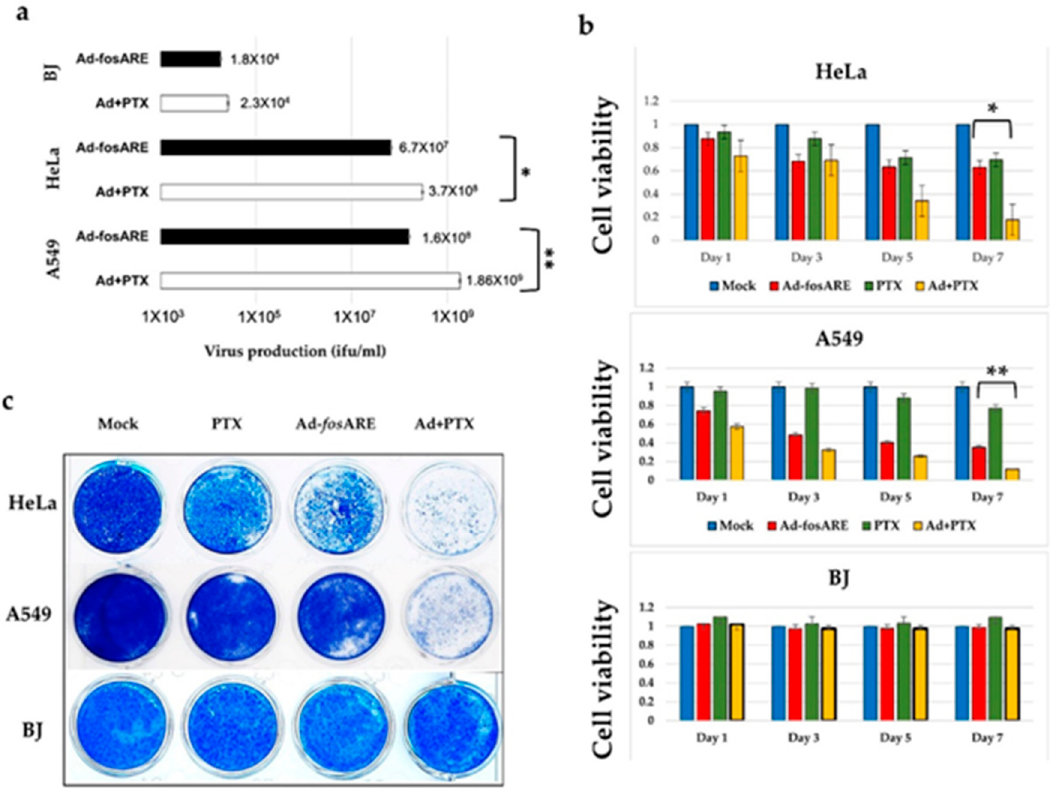
Figure 6. Assessment of combinatorial treatment’s e ff ect (Ad- fos ARE and PTX) on viral replication and cell lysis activity. ( a ) Cancer (HeLa and A549) cells and normal (BJ) cells were infected with Ad- fos ARE at an MOI of 10 ifu / cell and 4 nM PTX. Virus production was determined 48 h after through Hexon staining. Each titer (ifu / mL) is shown on the graph. Data are shown above as the mean ± standard deviation of three independent experiments. ( b ) Cell lysis activities of combination treatment were measured using the XTT assay. As mentioned above, cancer and normal cells were infected with the virus at an MOI of 10 ifu / cell and cell viabilities were estimated 1, 3, 5, and 7 days after infection. ( c ) Prior mentioned cancer and normal cells were subjected to staining with Coomassie brilliant blue 7 days after infection to observe cytopathic e ff ects. Living cells stained blue. (* indicates p < 0.05, ** indicate p < 0.01).